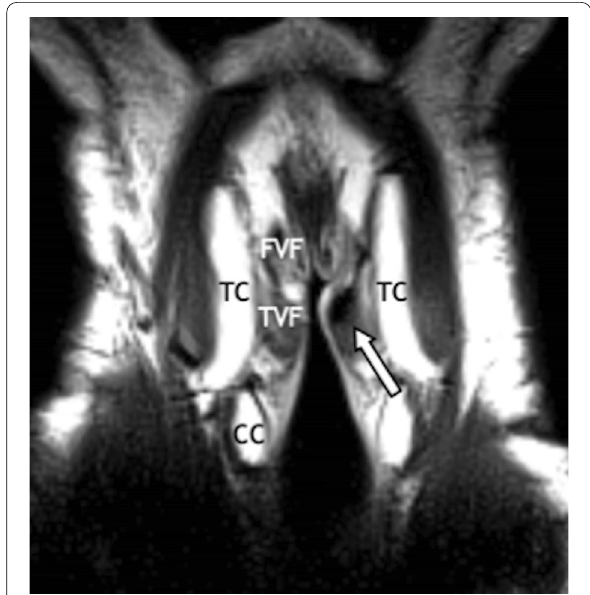
Fig. 9 Fibrosis of the left true vocal fold (arrow) in a 60-year-old man 3 years after ChT/RT for laryngeal cancer. Coronal T2-weighted MR image acquired with surface-coil MRI of the larynx shows hypointense signal of the left true vocal fold. TC, thyroid cartilage; CC, cricoid cartilage; FVF, false vocal fold; TVF, true vocal